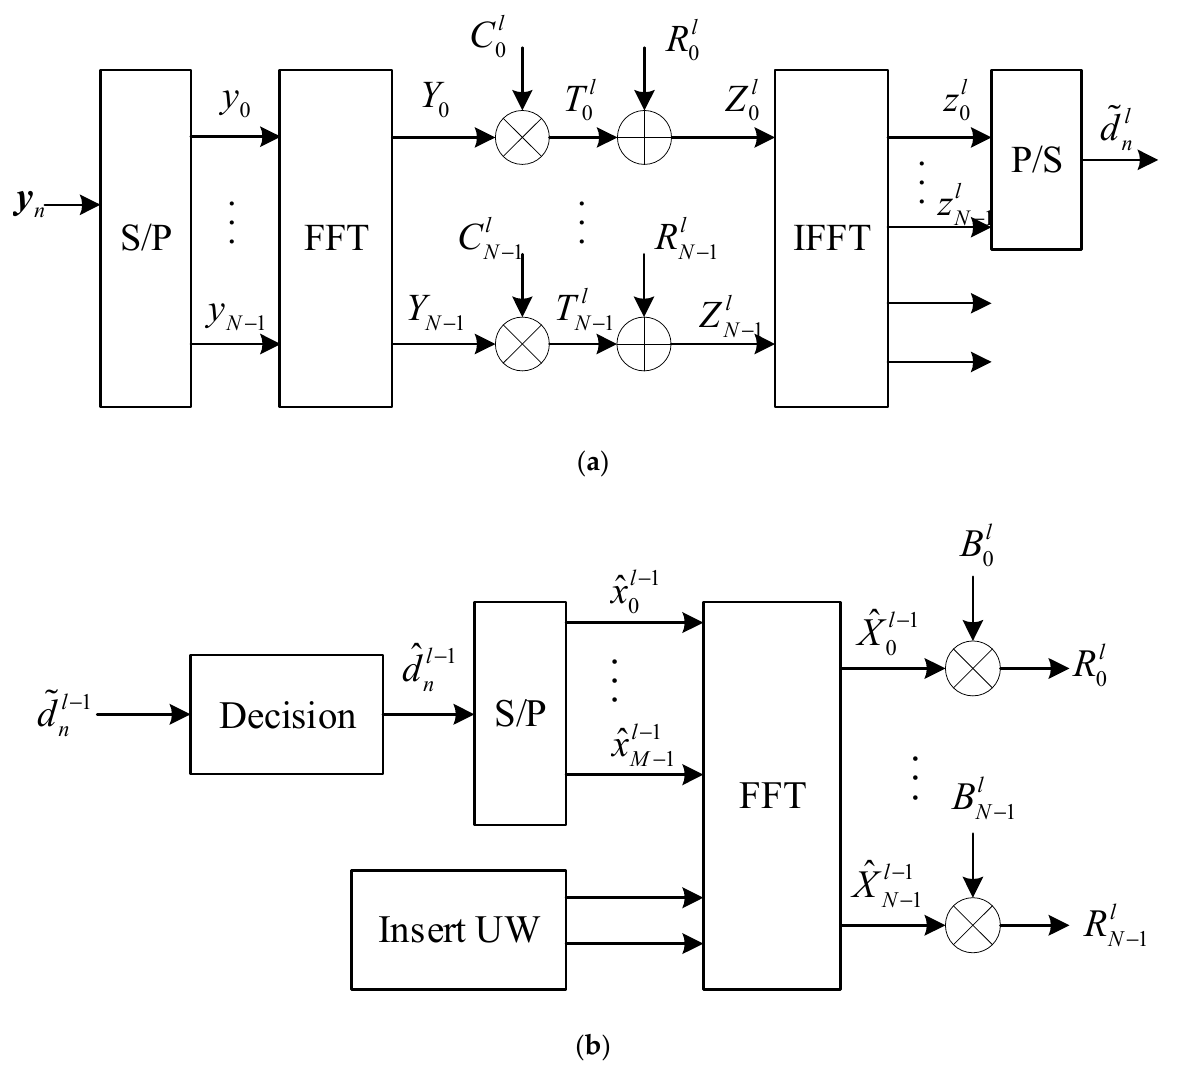
Figure 3. Schematic diagram of IBDFE. ( a ) Feedforward branch. ( b ) Feedback branch. (cid:111) (cid:111) (cid:110) (cid:110) B l C l In Figure 3, and represent the feedback filter coefficients and feedforward k k filter coefficients, respectively, where k = 0, 1, · · · N − 1, l = 1, 2, · · · N l , l represents the number of iterations. In the feedforward branch, the received signal is multiplied by